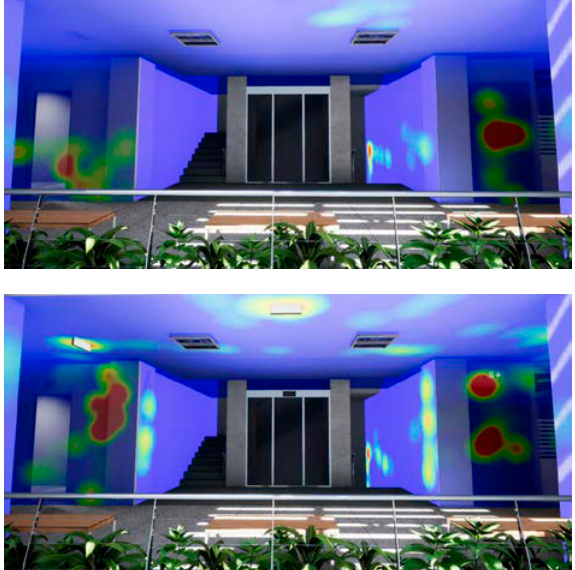
Figure 15-16: Eye-tracking data in the refurbished building of two tests, on the top the test without signals, down a test with